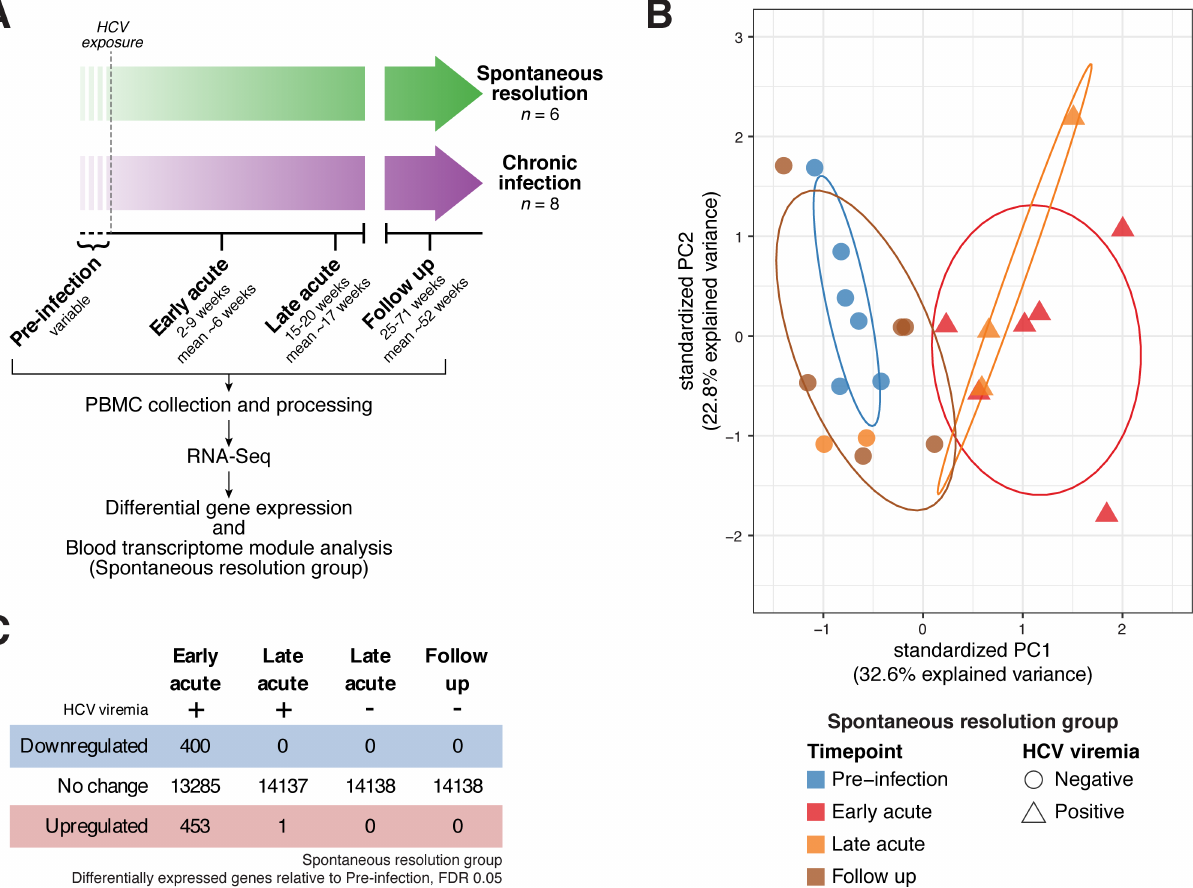
Fig 1. Study design and differential gene expression analysis in the Resolution group. (A) Overall study design. (B) Principal component analysis (PCA) of gene expression in the Resolution group (patient-specific gene expression variation removed as detailed in Materials and Methods). Color denotes time point, shape denotes HCV viremia status. Ellipses indicate 68% normal probability for each group (for Resolution group, Late Acute timepoint, ellipse plotted for positive HCV viremia samples only). (C) Summary of differential gene expression analysis results in the Resolution group. See also S1 and S2